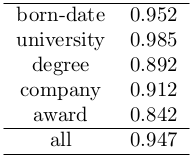
Table from the paper: IcoRating: A Deep-Learning System for Scam ICO Identification
Table text:
born-date
0.952
university
0.985
degree
0.892
company
0.912
award
0.842
all
0.947